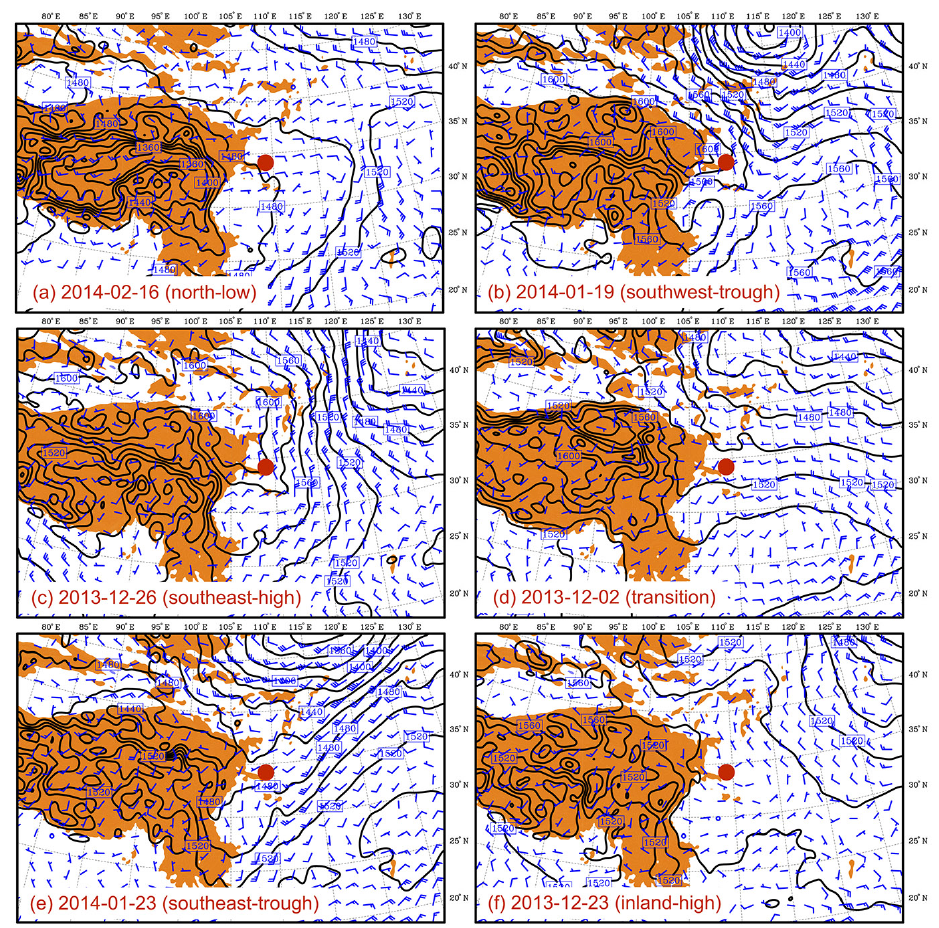
Figure 3. Distributions of winds and geopotential heights on 850hPa at 08:00BJT on (a) 16 February 2014 (“north-low”), (b) 19 January 2014 (“southwest-trough”), (c) 26 December 2013 (“southeast-high”), (d) 2 December 2013 (“transition”), (e) 23 January 2014 (“southeast- trough”), and (f) 23 December 2013 (“inland-high”). The red filled circle is Xi’an. The orange shading represents the terrain height over